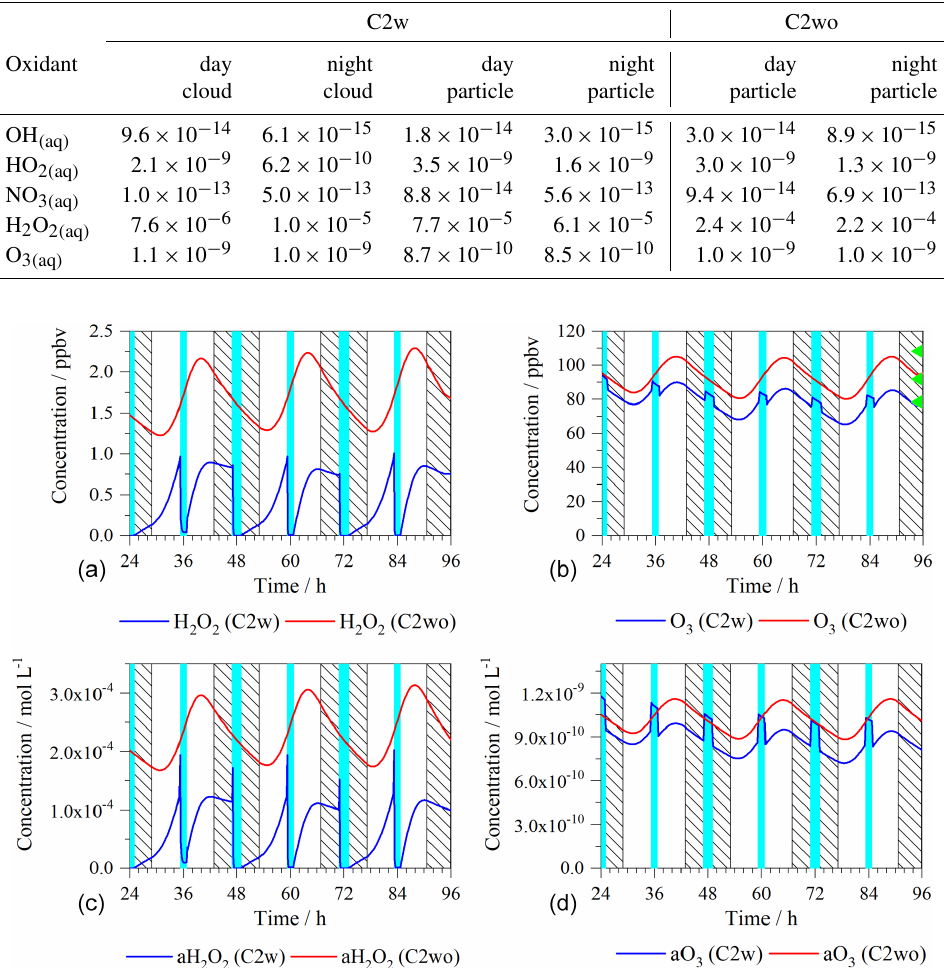
Figure 2. Time series of modeled gas-phase ( a, b ppbv) and aqueous-phase ( c, d molL − 1 ) non-radical oxidant concentrations in the C2w and C2wo cases. Light blue column: cloud; shadow: night; a: aqueous phase; green triangle: the maximum (above), average (middle), and minimum (below) value of measured concentration at Mt.